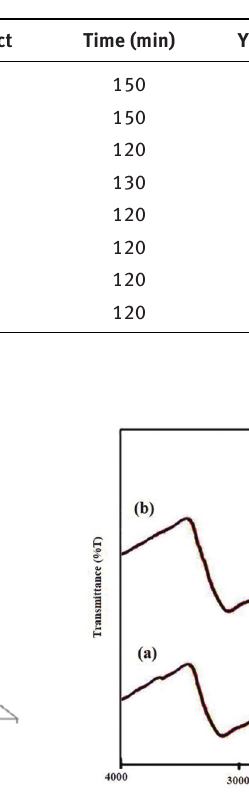
Table 2: Synthesis of pyrimidines by nano-Fe